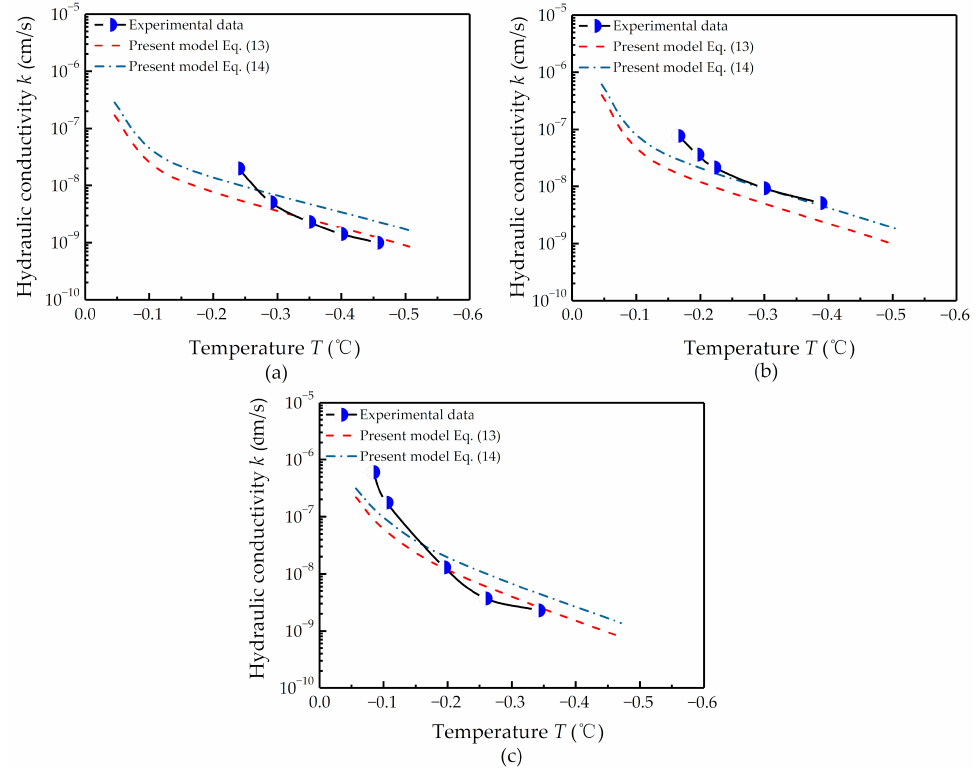
Figure 9. Comparison of the model results and experimental data. ( a ) Tokoro et al. [39] (silt); ( b ) Burt and Williams [7] (silt); ( c ) Burt and Williams [7] (clayey silt).